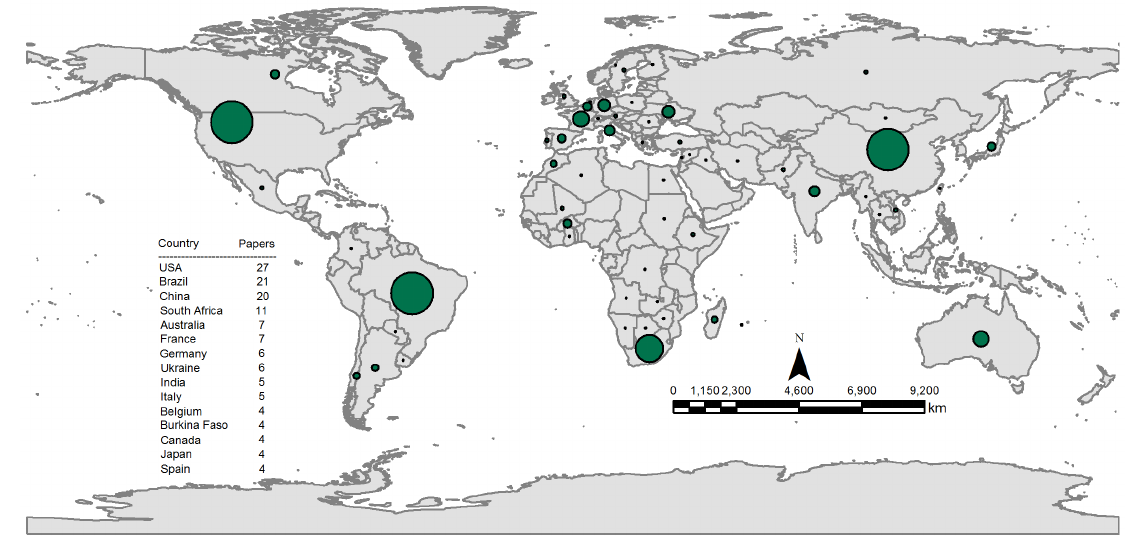
Figure 6. Global distribution of the study areas considered for applications in the selected papers, highlighting the 15 countries with the greatest number of